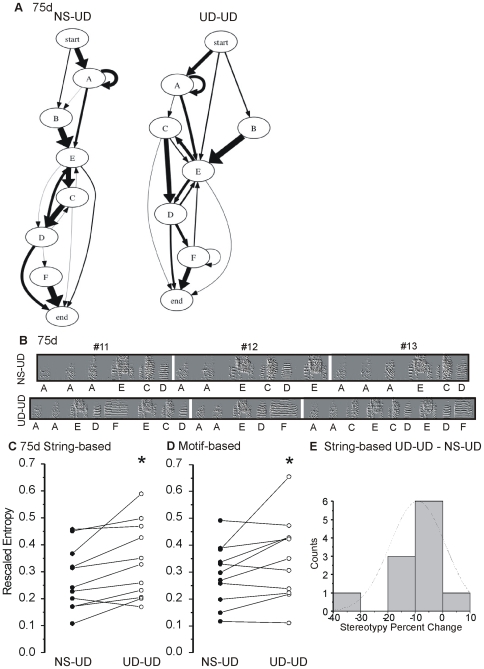
Sequence variability increases following continuous song practice at 75d.
A) Markov chains for one bird in the two conditions illustrate the probability of syllable transitions observed using the motif-based analysis. Letters denote syllables. Line thickness corresponds to probability; thicker lines indicate greater probabilities. In the NS-UD condition, syllable E transitions to syllable C 83% (thick line) of the time whereas a thinner line represents a 16% probability that E ends the motif. By contrast, in the UD-UD condition, syllable E transitions to syllable C 50% of the time, to syllable D, 43%, and ends the motif 7%. In the NS-UD condition, syllable F occurs infrequently compared to the UD-UD condition. B) Examples of 3 consecutive motifs from the same 75d bird in the NS-UD and UD-UD conditions. Motifs occurred in the same chronological order in the selected 20 motifs analyzed (#11,12,13). Individual syllables are identified by letter. In the NS-UD condition, syllable A typically transitions to itself or to syllable E, and syllable C transitions most frequently to syllable D. By contrast, in the UD-UD condition, A also transitions to C (#13) as well. In the UD-UD condition, syllable F is observed (#11,12,13) and follows syllable D while in NS-UD, syllable D transitions to E (#12) or ends the motif (#11,13). C–D) Paired data scores for the NS-UD (filled circles) and UD-UD (open circles) conditions for each bird are represented by connected lines. At 75d, songs sung in the UD-UD condition exhibited greater variability (*, 2-tailed paired bootstrap ‘Rescaled Entropy’) compared to the NS-UD condition for both the string- (C, p<0.005) and motif-based analysis (D, p<0.05). E) Histogram reveals the percent change in stereotypy between the conditions.